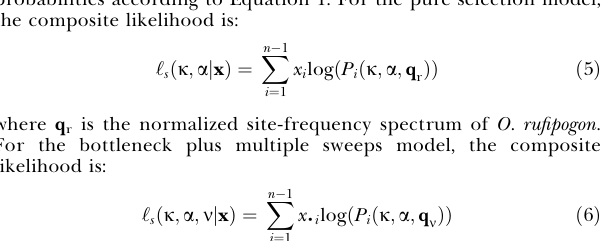
Figure S1. Clustering of Oryza Accessions Based on Neighbor-Joining Analysis of Concatenated STS Sequences Numbers by branches are bootstraps of 1,000 replicates. Only branches with a bootstrap value higher than 60% for major clades